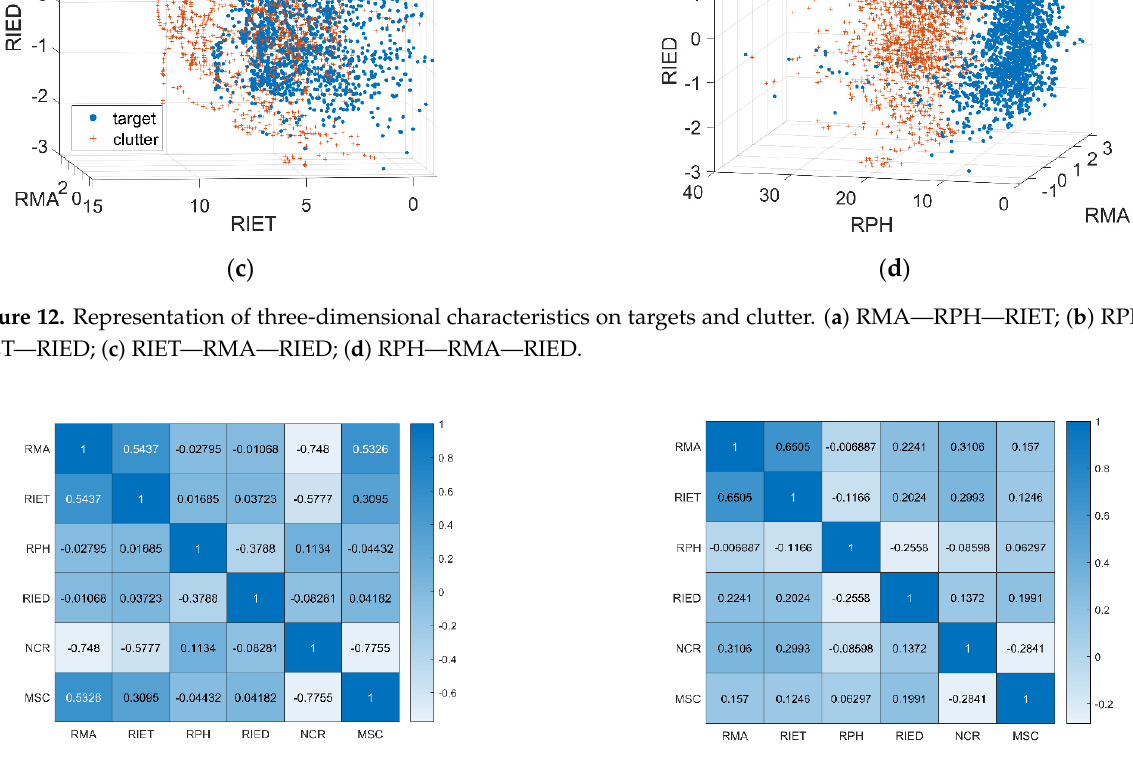
Figure 12. Representation of three-dimensional characteristics on targets and clutter. ( a ) RMA—RPH—RIET; ( b ) RPH— RIET—RIED; ( c ) RIET—RMA—RIED; ( d ) RPH—RMA—RIED.